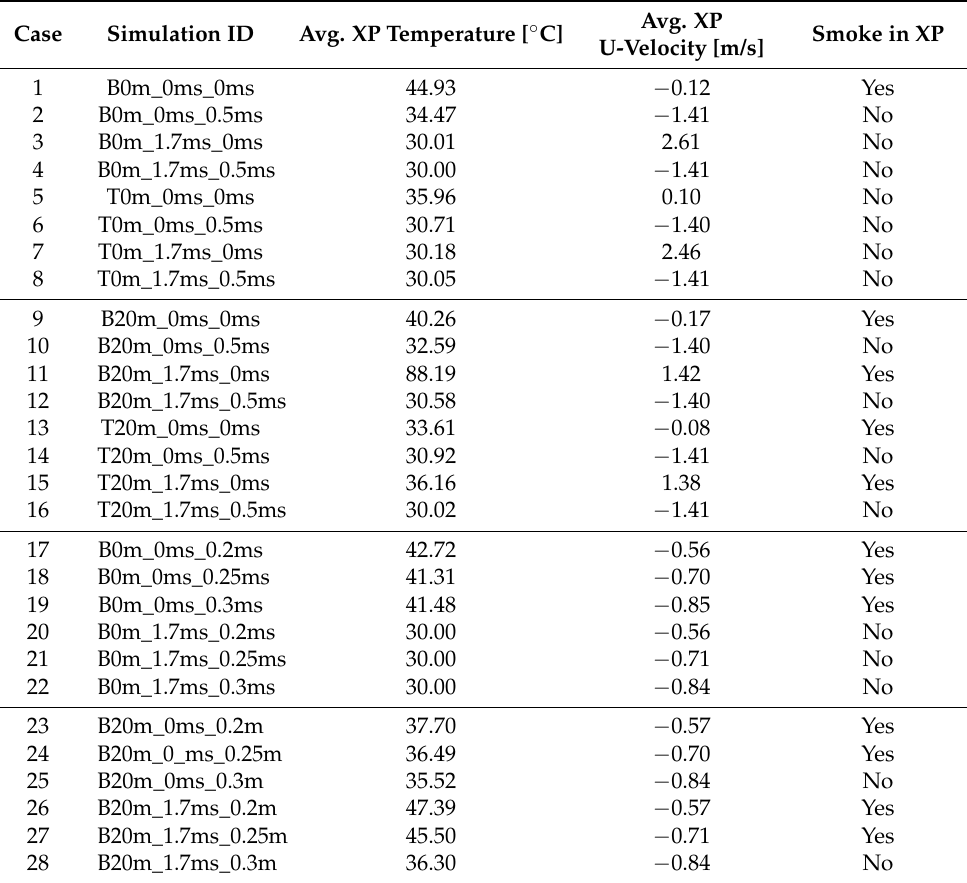
Table 2. Summary of the smoke movement in cross-passages (XP) for different longitudinal tunnel and cross-passage velocities. Cases with cross-passage smoke are highlighted in orange, and the cases with no smoke are highlighted in